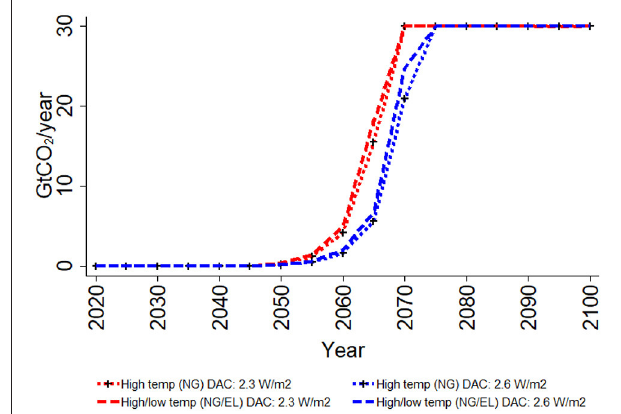
FIGURE 1 | The deployment of DAC under the least cost strategy scenarios that aim to achieve climate mitigation goal by limiting the total radiative forcing to 2.3 W/m 2 by year 2100 (shown in red color) and 2.6 W/m 2 by year 2100 (shown in blue color), respectively. The scenario “High temp (NG) DAC” shows deployment of high temperature natural gas-based DAC in addition to BECCS and AR, and the scenario “High/low temp (NG/EL) DAC” shows aggregate deployment of three types of DAC (high temperature natural gas-based DAC, high temperature electricity- based DAC and low temperature electricity-based DAC) in addition to BECCS and